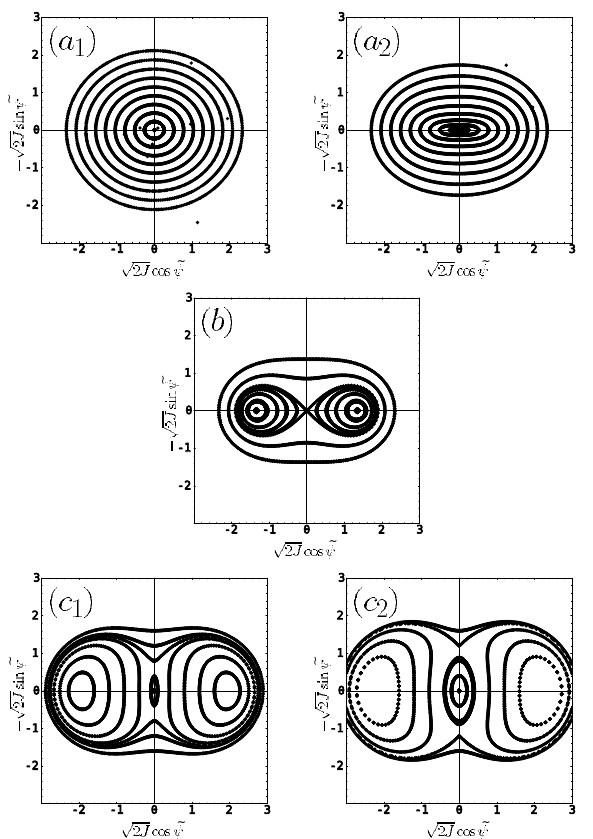
FIG. 1. Particle trajectories in a surface of a section of the Hamiltonian (4) with the parameters n s (cid:1) 0.0005 and e (cid:1) 0.45 . In part (a1) the modulation tune n m (cid:1) 0.0018 is above and far away from the parametric resonance interval, in part (a2) it is still above but with n m (cid:1) 0.0011 close to this interval. Part (b) shows the situation with n m (cid:1) 0.001 , when the parametric resonance is excited. Parts (c1) and (c2) depict the cases with n m (cid:1) 0.000 87 and n m (cid:1) 0.0008 , respectively, when the modulation tune is below the parametric resonance and either close or far away from that